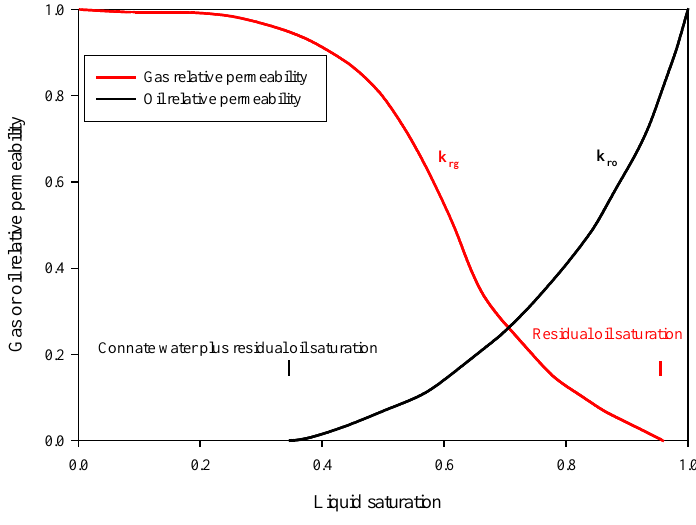
/ liquid-relative permeability Figure 1. Typical curve of gas/liquid-relative permeability [7]. Figure 1. Typical curve of gas